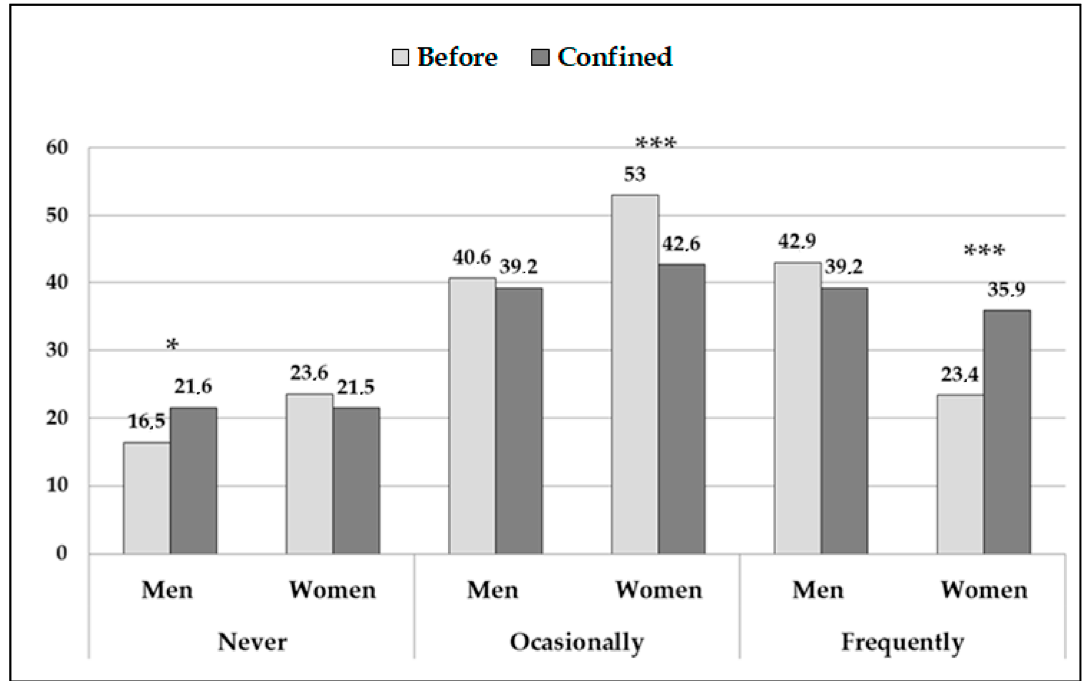
Figure 1. Frequency of physical activity carried out before and after the lockdown. Data provided in %. The asterisks indicate the significant di ff erences in the proportion of men and women within the same response option before and during lockdown: * p < 0.05; *** p <